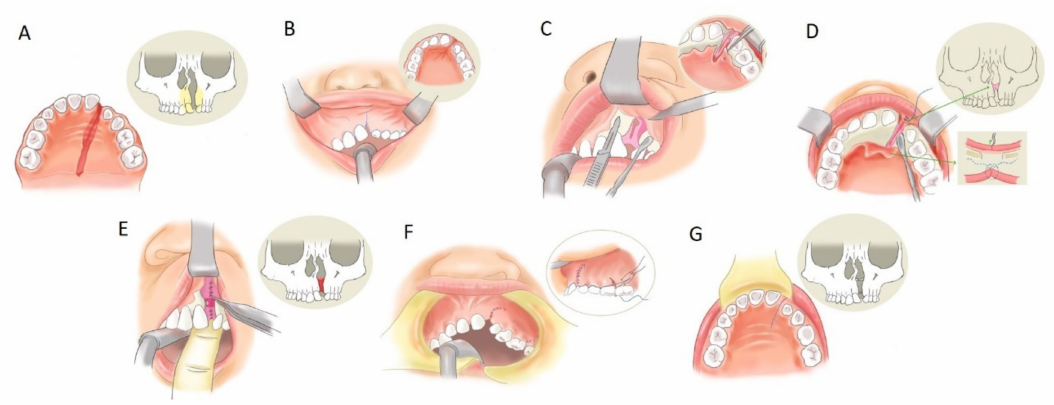
Figure 1. Extensive gingivoperiosteoplasty. Alveolar cleft and bone defect ( A ). Incision line made on the upper gingiva along with the cleft ( B ). The gingival mucoperiosteal flap, in which the blood supply comes from the superior part, was elevated to explore the cleft ( C ). The palatal mucoperiosteal flap deep to the margin of the alveolar fistula was elevated ( D ). Then, the tissue of the nasal floor was watertight sutured ( E ). The bone graft was packed into the cleft area at this step (secondary alveolar bone grafting (SABG) method). The gingival site and palatal site wound were closed completely ( F,G